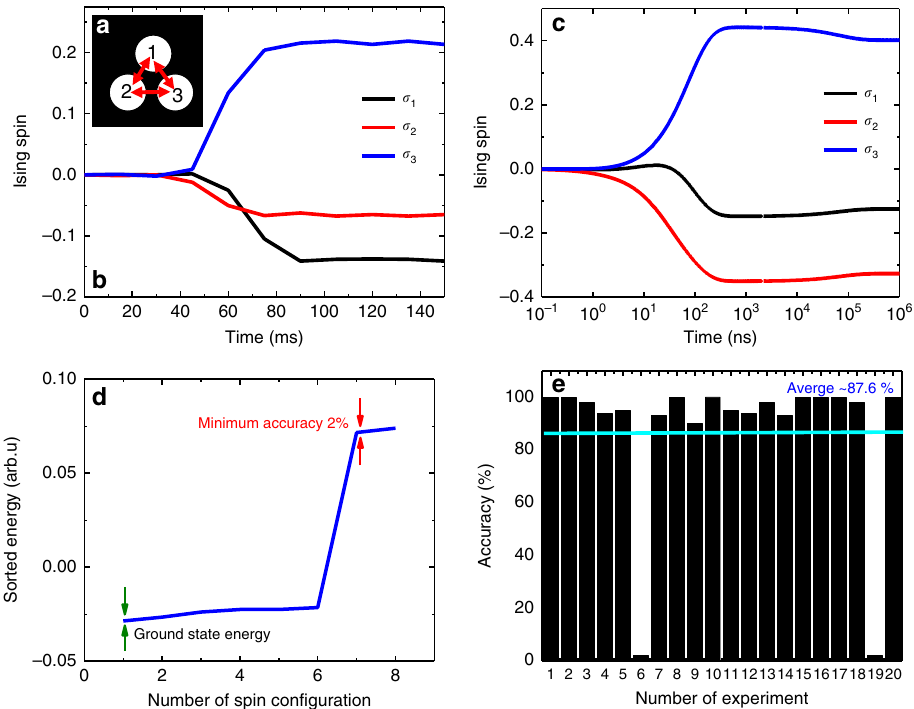
Fig. 8 Ising Hamiltonian with N = 3. a Fully connected grating design for the mutual coupling matrix. b Experimental Ising spin evolutions as the function of time. c Simulation result of the given Ising Hamiltonian. The CIM simulation found exact ground state. d Sorted Ising energy values for the eight possible con fi gurations. e Accuracy versus number of experiment. The overall average accuracy of the CIM for the designed Ising Hamiltonian in a was 87.6%. The CIM found the ground state 8 times out of 20 times experiment and trapped twice to an accuracy of